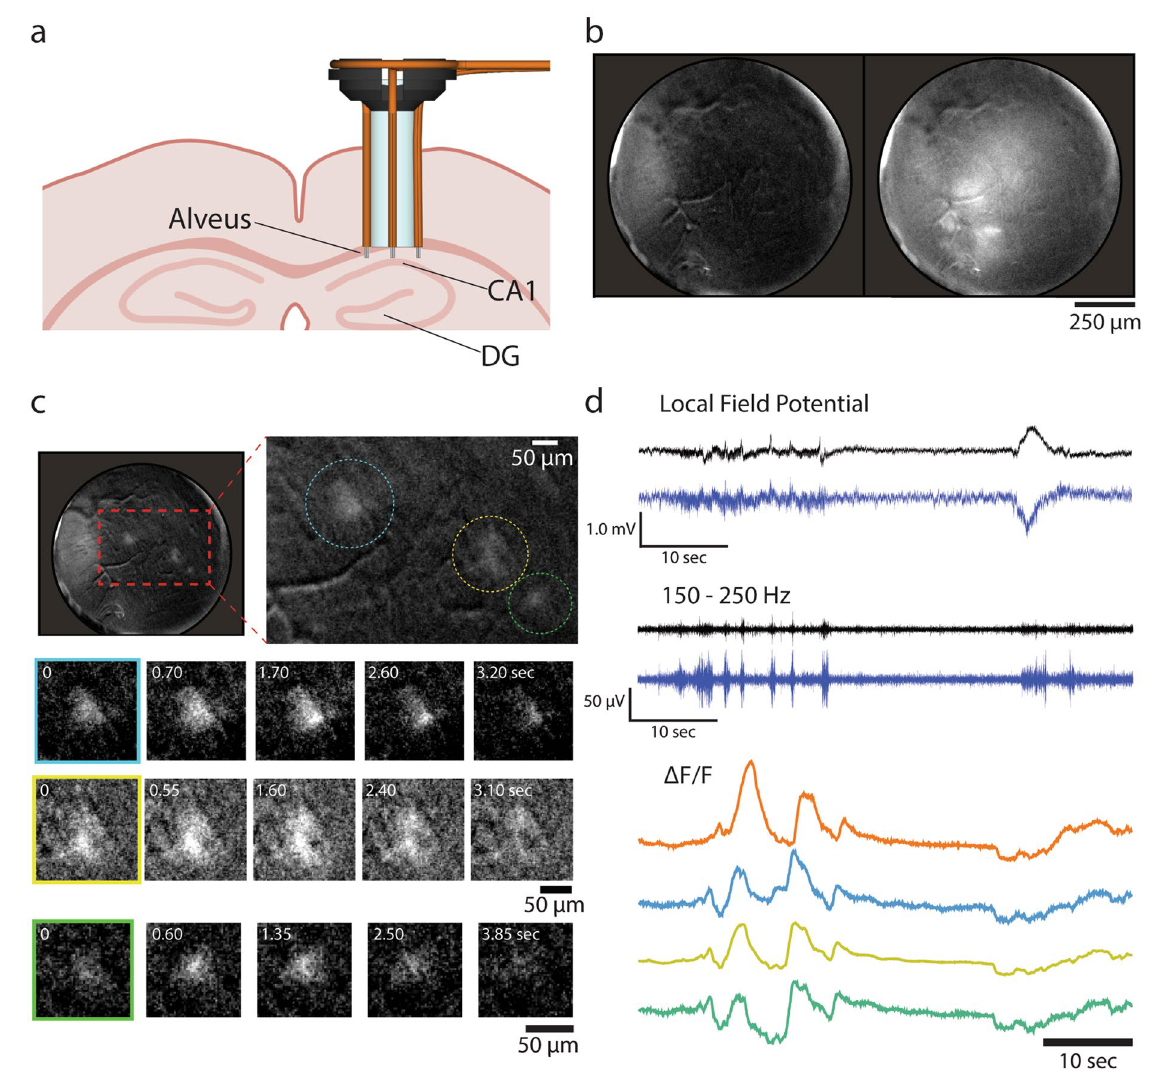
Figure 4. Bimodal recording of astrocyte activity and LFP in the CA1 area using a GRIN lens-wire electrode assembly. ( a ) Position of an electrode-lens assembly in the mouse brain. ( b ) Large, dispersed calcium signalling events. Left: A frame before a large calcium event. Right: A frame at the peak of a large calcium event. Most of the field of view also shows changes in fluorescence, potentially involving the coordinated increase in intracellular calcium concentration of multiple astrocytes that were beyond the focal plane. The circular edge in the images corresponds to the edge of the GRIN lens. ( c ) Calcium signalling events in individual astrocytes. Top, a frame showing three astrocytes exhibiting a calcium event simultaneously. Bottom, magnified images of the three astrocytes (blue, yellow and green, corresponding in the Top right image) over five time points. ( d ) Bimodal recording of LFP and astrocytic calcium signalling activity in the CA1 area. Electrical and optical signal traces are temporally matched. All images and traces in this figure were taken 1 week after electrode and lens implantation